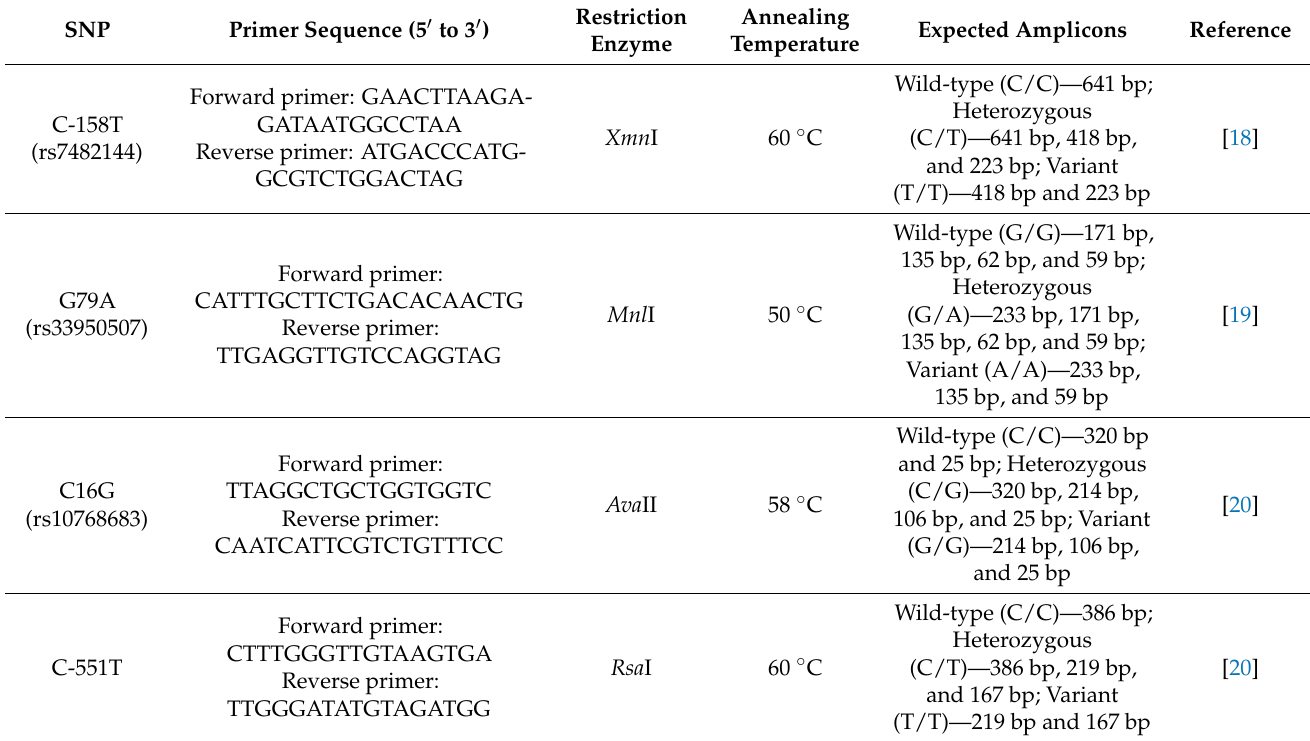
Table 1. Primers used and PCR-RFLP conditions for the SNPs in this